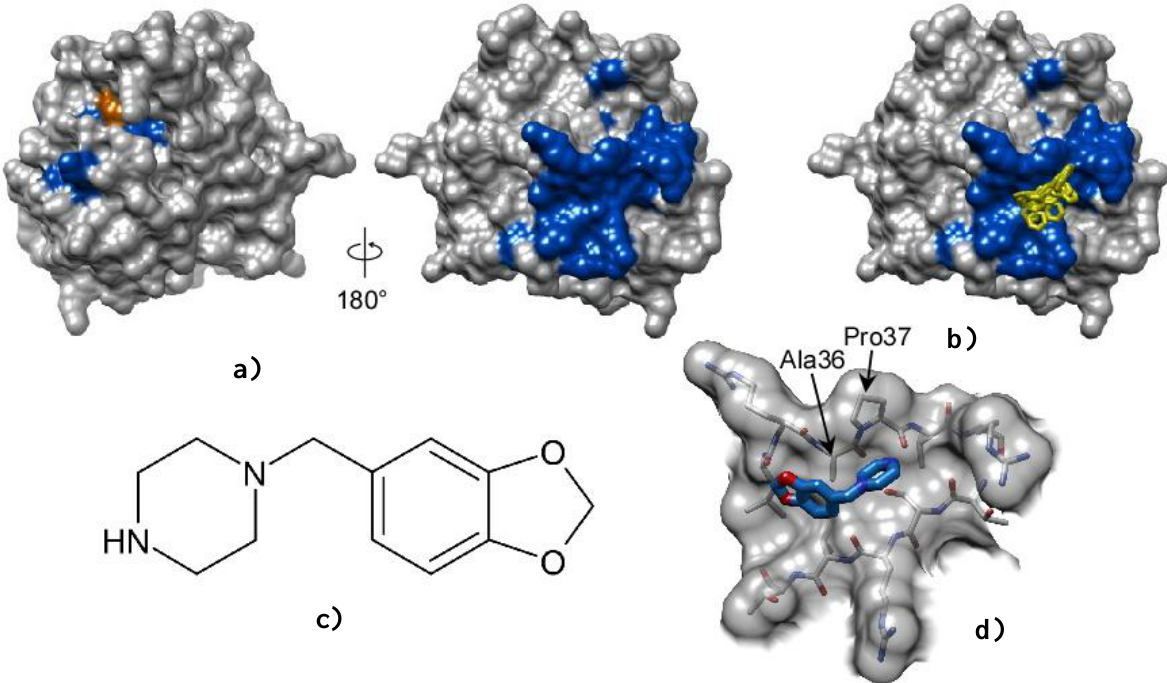
Figure 3. Interaction and docking of E. coli Pth1 with piperonylpiperazine. ( a ) Surface representation of E. coli Pth1 (PDBID:2PTH) shown with catalytically important His20 in orange. From NMR data, residues with 1 H– 15 N resonances affected by interaction with piperonylpiperazine are in blue; ( b ) Docking: The six lowest energy orientations of piperonylpiperazine are shown in yellow; ( c ) Structure of piperonylpiperazine; ( d ) An enlarged view of the piperonylpiperazine binding